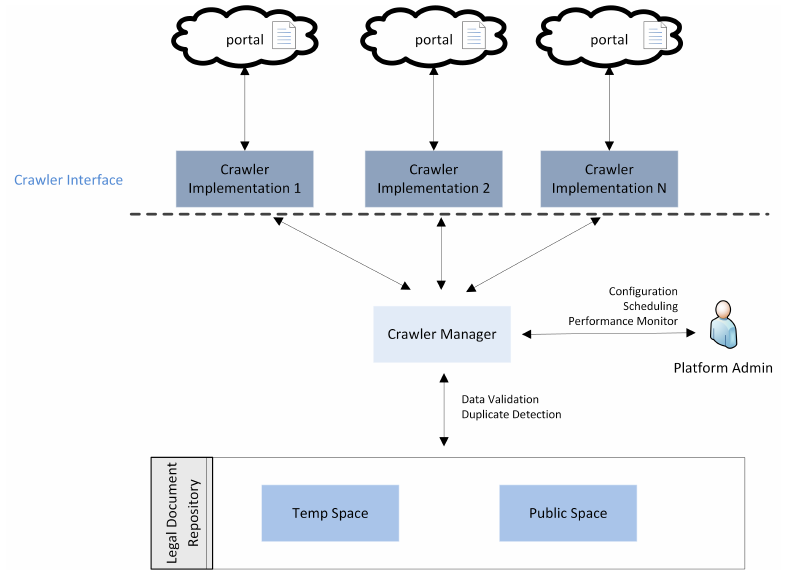
Figure 6. Crawler Architecture. A Crawler manager, interacting with the Legal Document Repository, coordinates discrete crawler implementations, extending a common Crawler interface, that harvest specific information